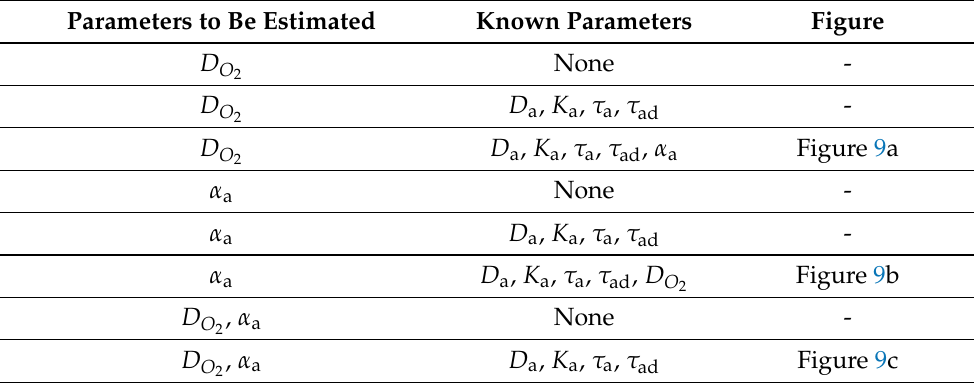
and α a in the utility 2